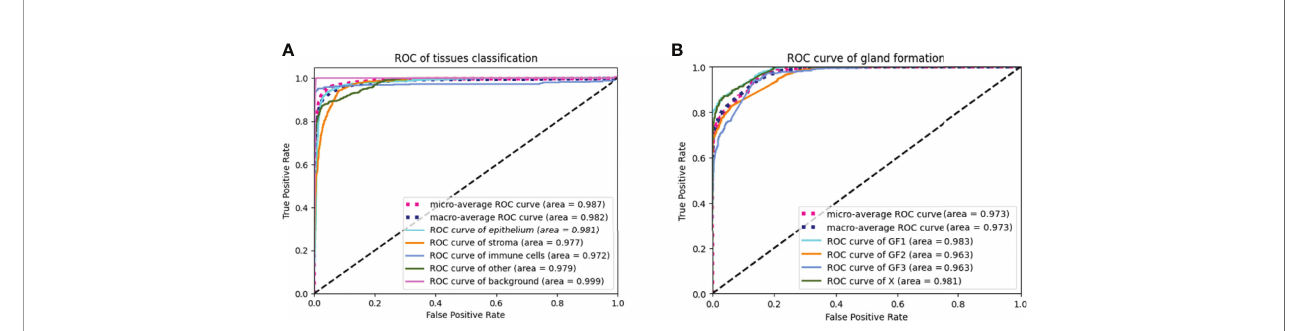
FIGURE 2 | ROC curves of the tissue classi fi er and the gland formation classi fi er (A) showed ROC curves of the tissue classi fi er. The AUC were 0.987, 0.982, 0.981, 0.977, 0.972, 0.979 and 0.999 for micro-average ROC, macro-average ROC, epithelium, stroma, immune cells, other and background, respectively. (B) showed ROC curves of the gland formation classi fi er. The AUC were o.973, 0.973, 0.983, 0.963, 0.963 and 0.981 for micro-average ROC, macro-average ROC, GF1, GF2, GF3 and X,